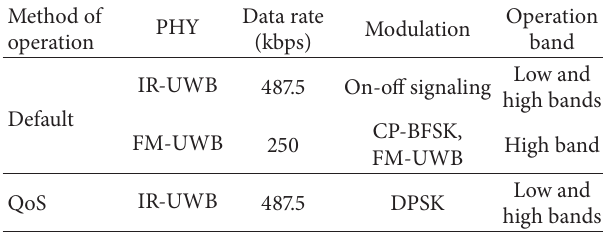
Table 4: UWB physical layer modulation techniques